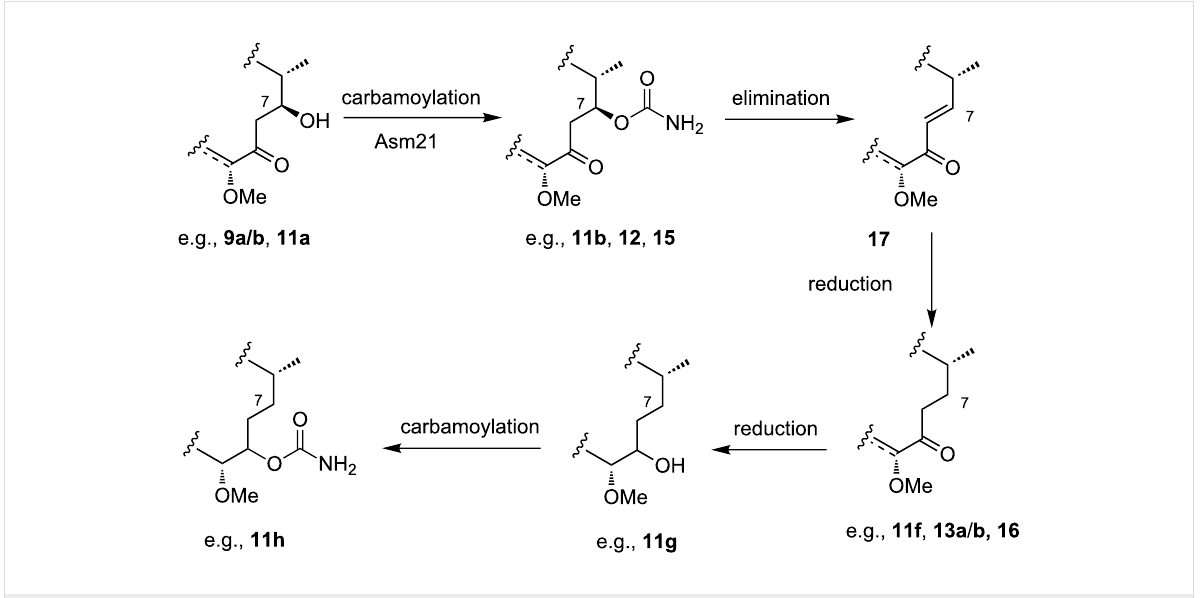
Scheme 5: Possible mechanism of deoxygenation at C-7 of proansamitocin